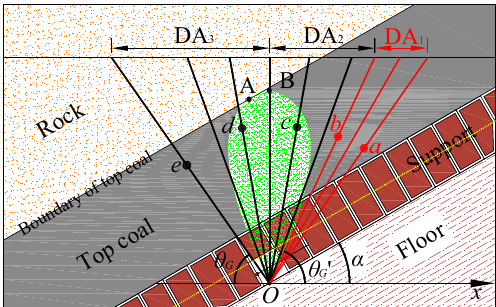
Fig. 6 Theoretical model of the drawing body in the initial drawing stage in an inclined